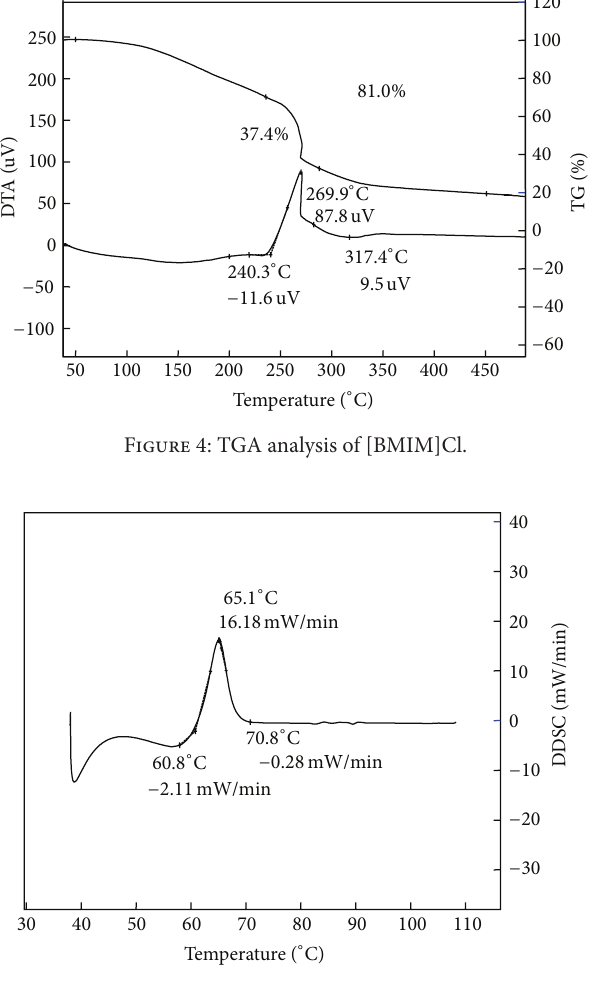
Figure 5: DSC analysis of [BMIM]Cl.